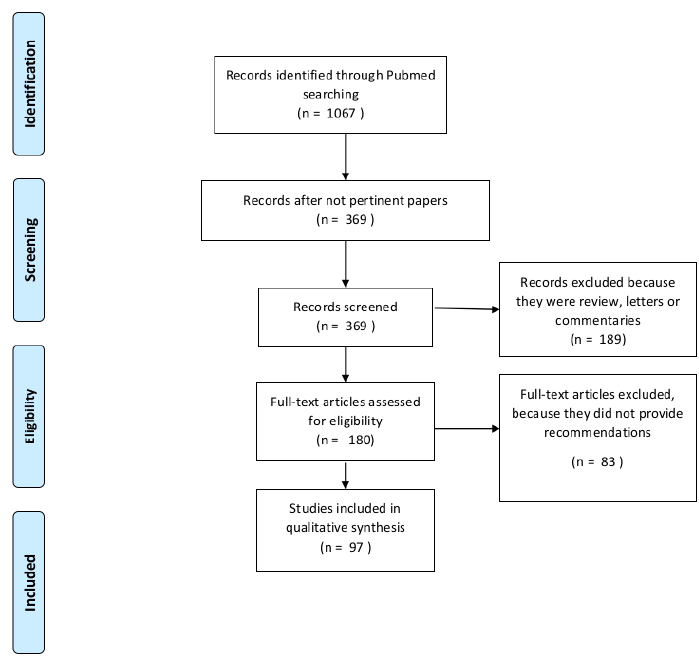
Figure 1. Flow diagram of included studies.